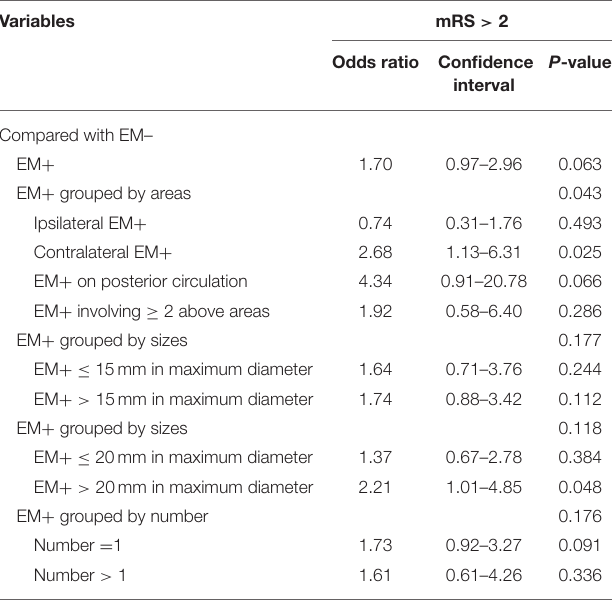
TABLE 3 | Multivariable logistic regression between pre-existing encephalomalacia (EM) and outcome stroke outcome at 3